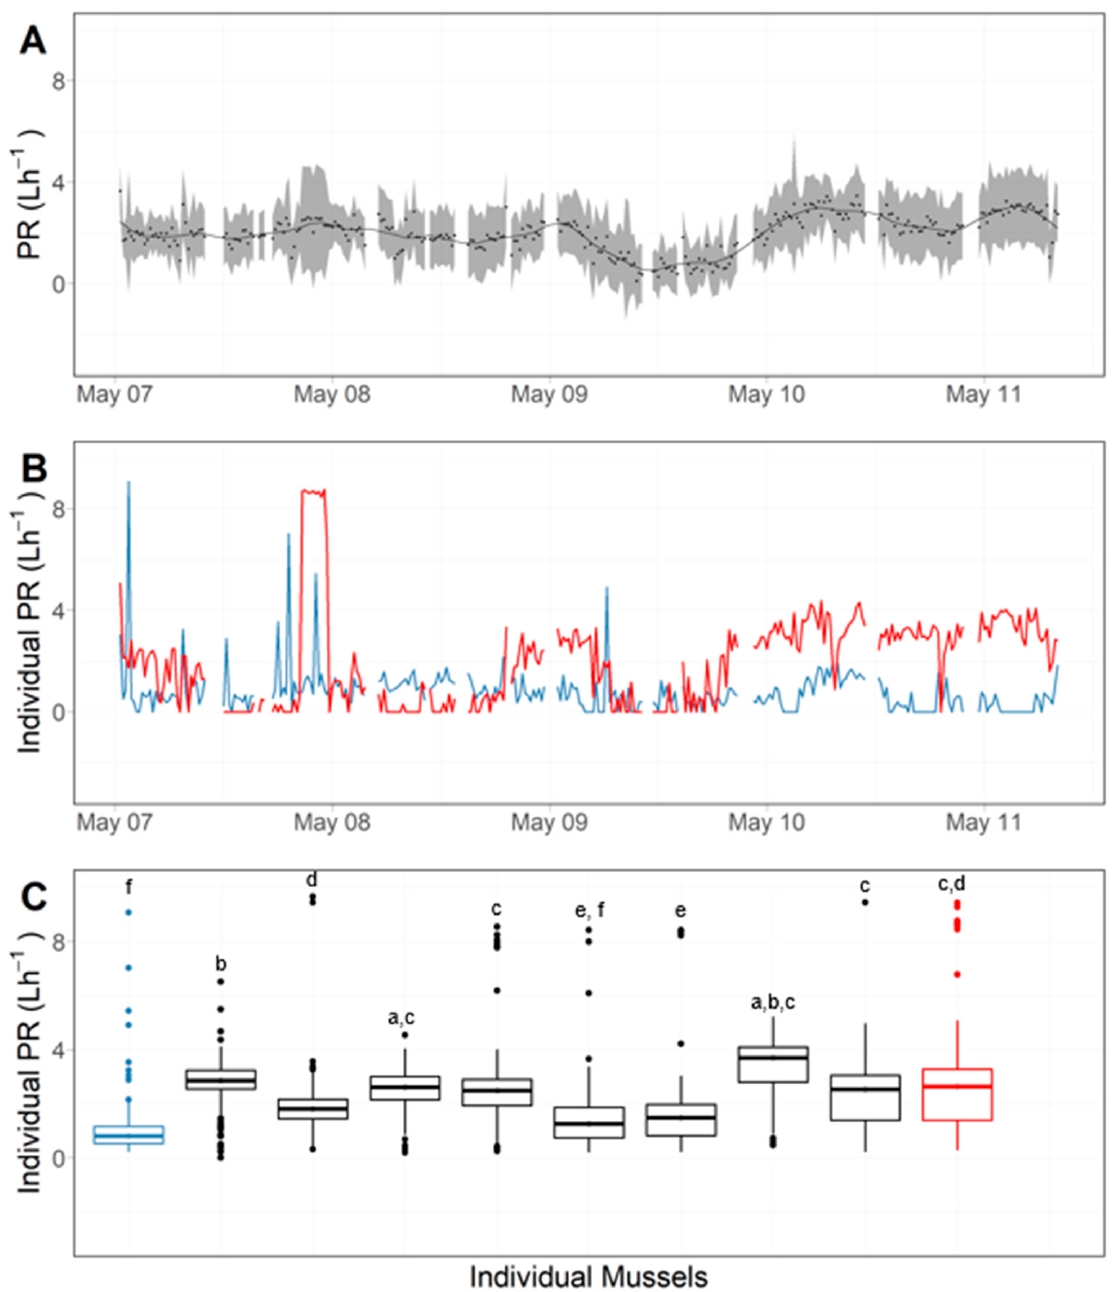
Figure 1. Summary of pumping rate (PR) (Lh − 1 ) data from Exp. 1: ( A ) Median PR of all individuals ± SD over 4 days. ( B ) Individual PR of two mussels with lowest (blue) and highest (red) interquartile range in PR. ( C ) Boxplots of summarized PR of all individuals over the entire experiment; letters a–f above boxplots indicate statistically significant differences at p < 0.0001.